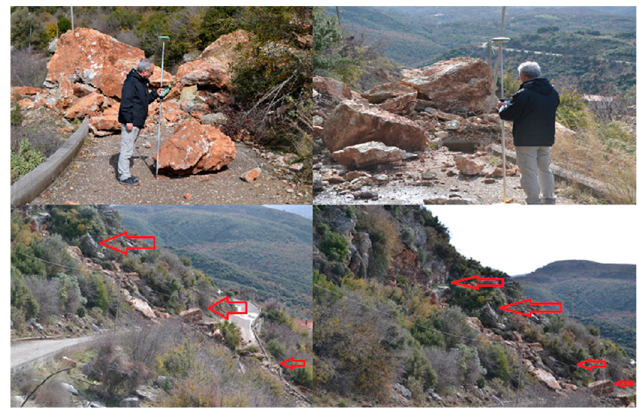
Figure 5. Pictures taken from Myloi region after rockfall event.